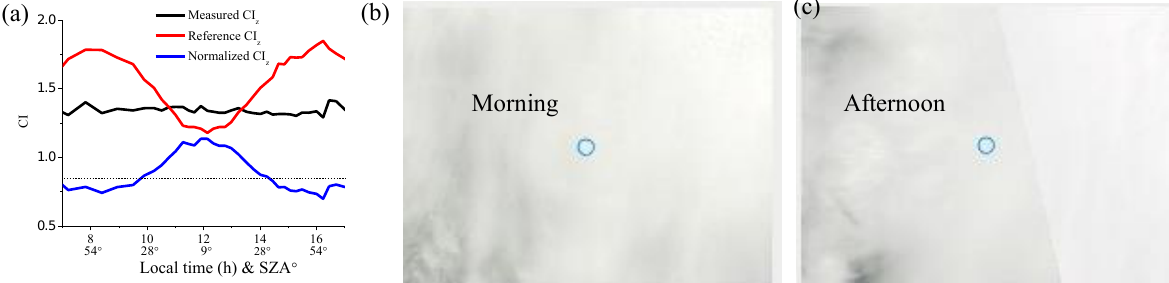
Figure 6. (a) The black, red and blue curves indicate the time series of the measured zenith CI z , the corresponding reference CI z and the normalized CI z , respectively, on 8 July 2012. The dashed line presents the threshold of normalized CI of 0.84. The visual images in the morning (b) and in the afternoon (c) from MODIS indicate cloudy skies over the Wuxi site on the